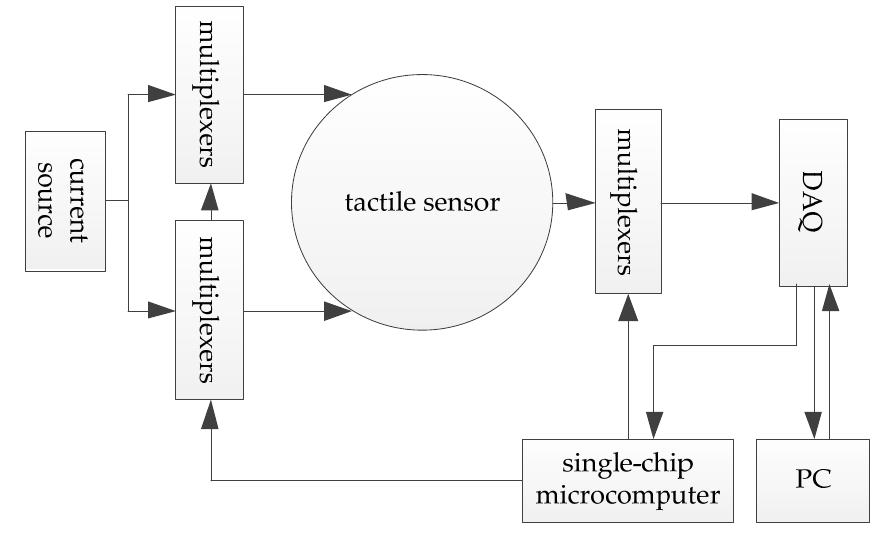
Figure 5. The diagram of the circuit.